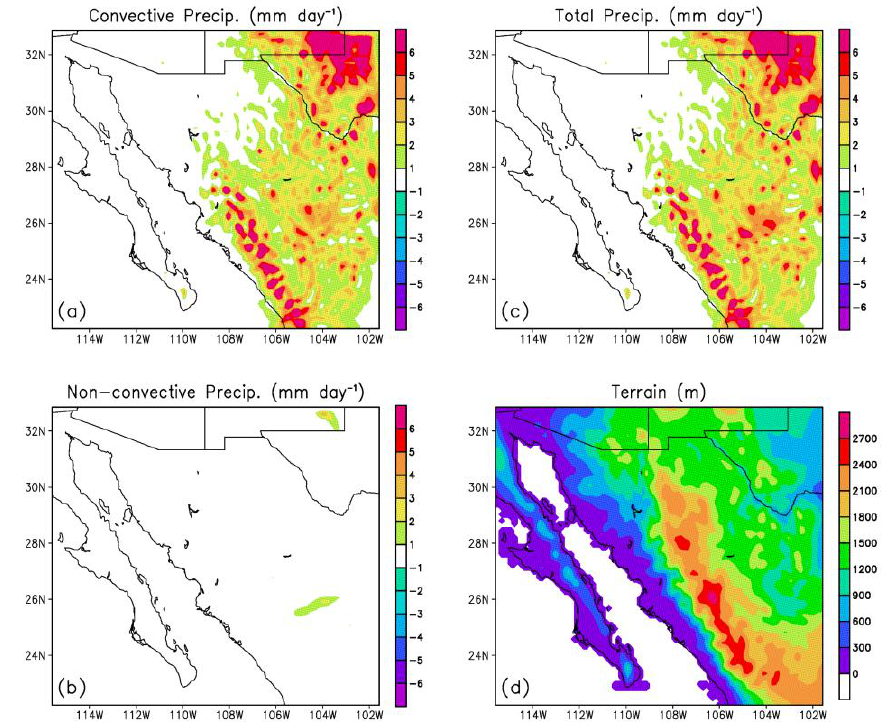
Figure 1. (a)–(c) 10-day mean (a) convective; (b) non-convective; and (c)